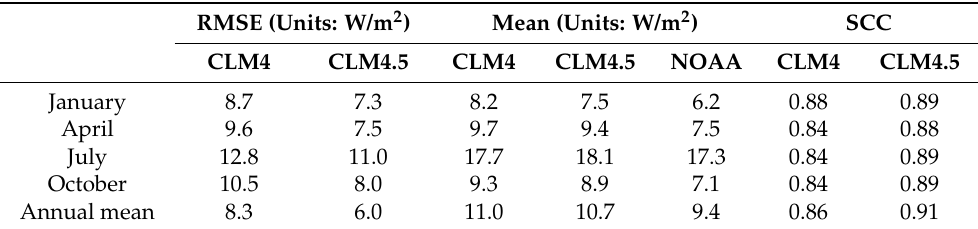
Table 2. RMSEs, means and spatial correlation coefficients (SCC) for globally Et in January, April, July and October and annual